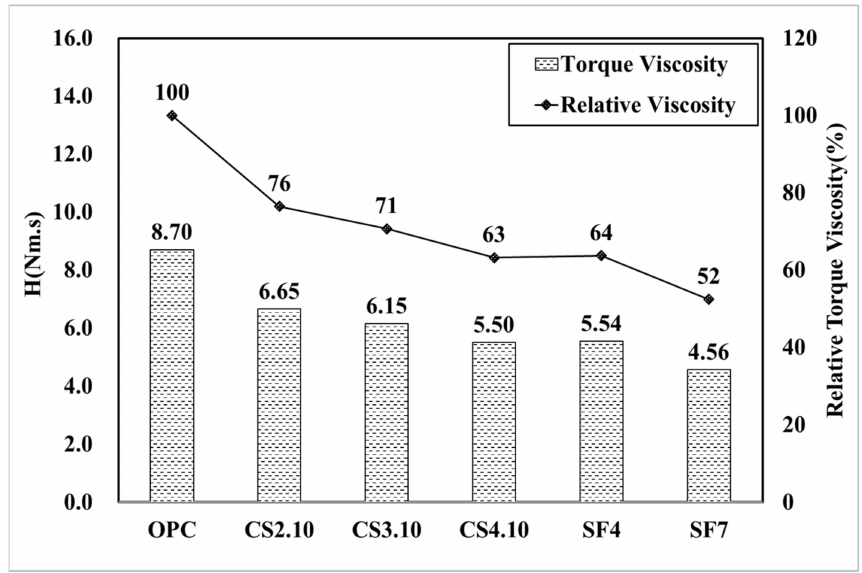
Figure 11. Torque viscosity (H) of the mixing